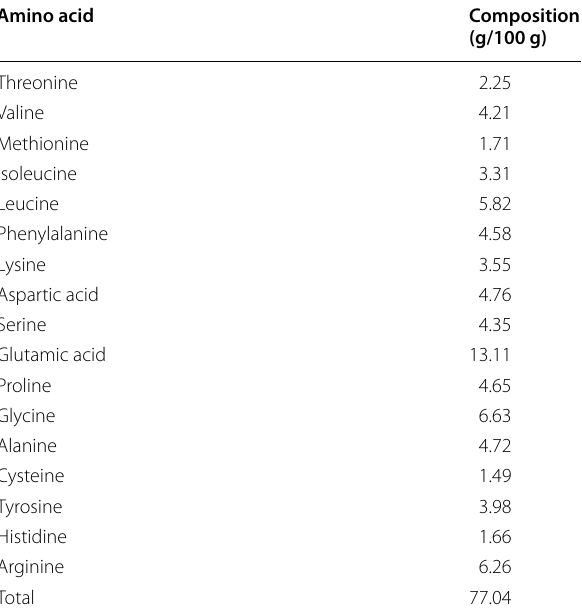
Table 7 Amino acid composition of protein extracted from rubber seed Amino acid